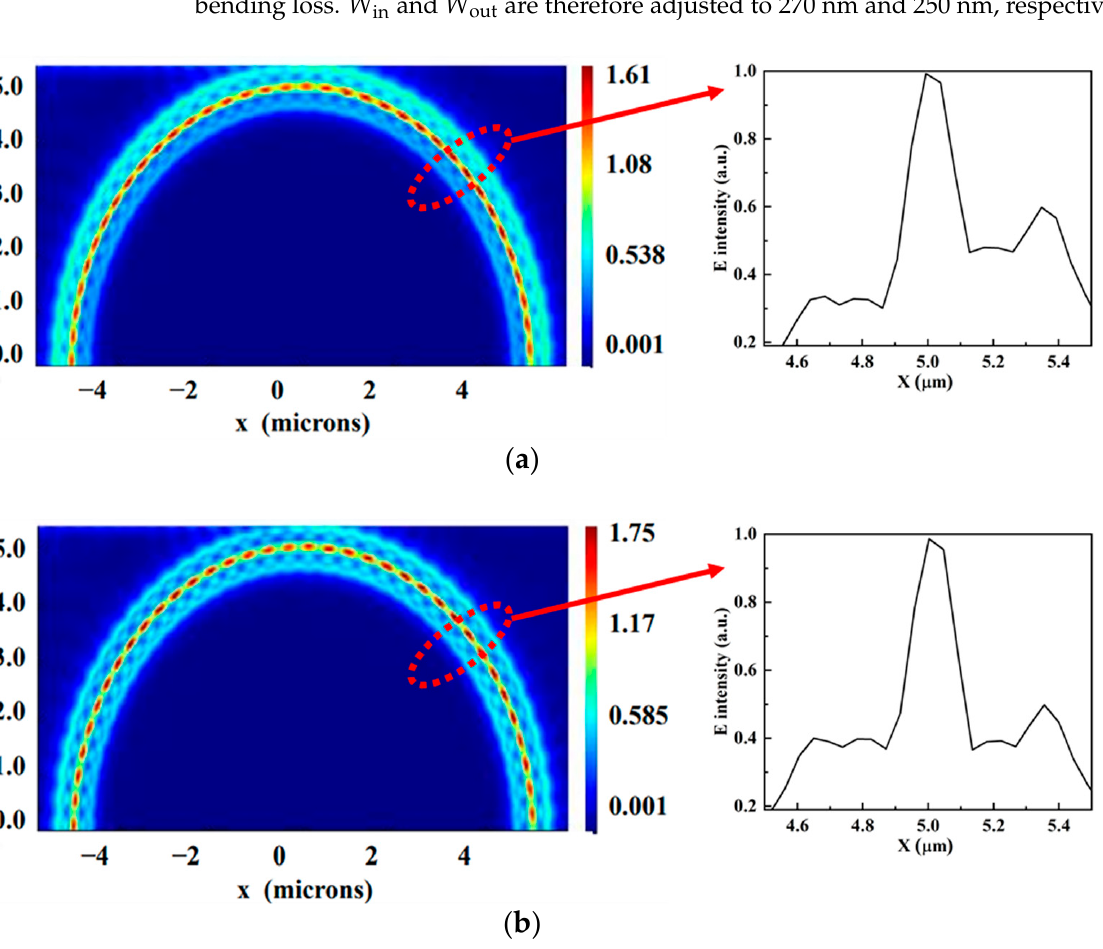
Figure 5. ( a ) Electric field distribution with W in = W out = 260 nm. ( b ) Electric field distribution with W in = 270 nm, W out = 250 nm. The inserts show the normalized electric field distribution of the X cross